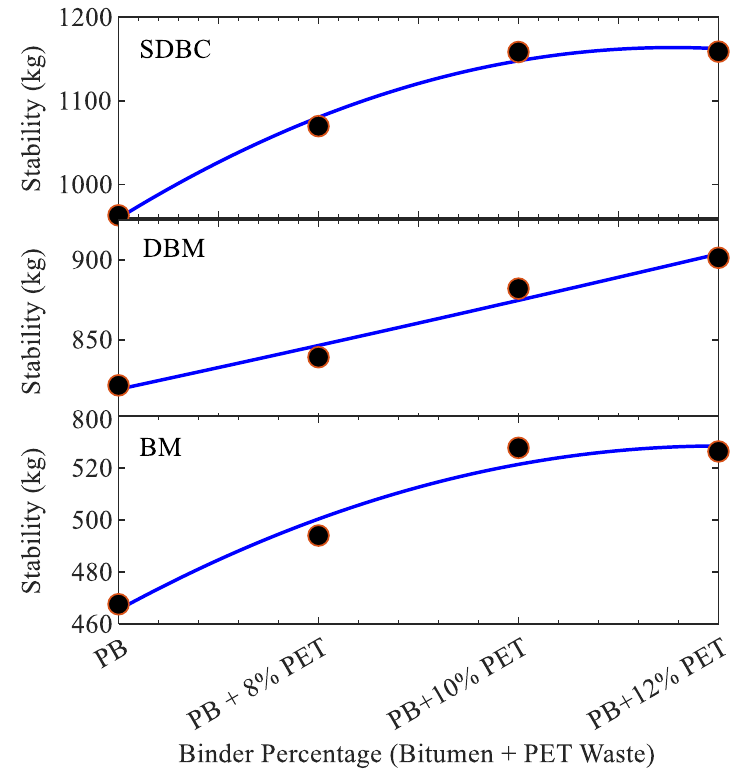
Fig. 24 Relations between Marshall stability and binder content for modified SDBC, DBM, and